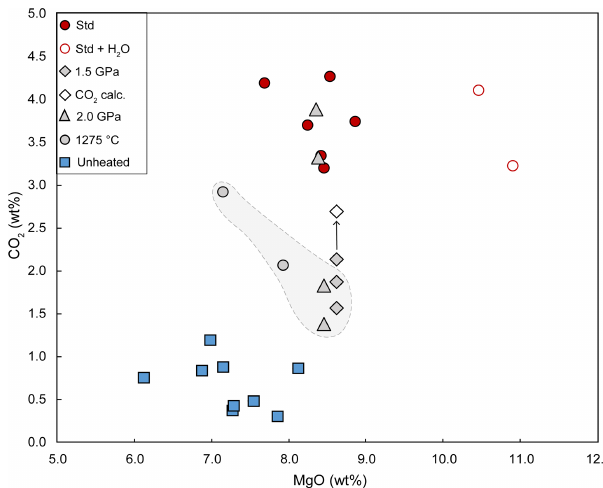
Figure 9. CO 2 contents in glasses plotted as a function of MgO. Symbols are as follows: solid blue squares, unheated melt inclu- sions; red circles, homogenization experiments at 2.5GPa–1300 ◦ C without water (solid red circles) or with added water (empty red cir- cles); solid grey diamonds, experiment at 1.5GPa–1300 ◦ C; solid grey triangles, experiments at 2GPa–1300 ◦ C; and solid grey cir- cles, experiment at 2.5GPa–1275 ◦ C. The solid grey diamond and empty diamond joined by an arrow corresponding to melt inclusion HOP no. 10a-MIb: the empty diamond shows the total CO 2 con- tent estimated by adding the CO 2 contained in the residual bubble to the CO 2 dissolved into the glass. With the exception of this one, all the melt inclusions presented are bubble-free and completely ho- mogenized. The grey area surrounded by a dashed line corresponds to the melt inclusions that may have undergone CO 2 loss through cryptic decrepitation (see Sect. 4.5 for explanation). The MgO con- tents correspond to the values after normalization to 100wt% of the sum of major and minor elements (on a volatile-free basis); the CO 2 contents correspond to the values after PEC/PED correction (or to the raw data when the glass composition was not analyzed with the electron